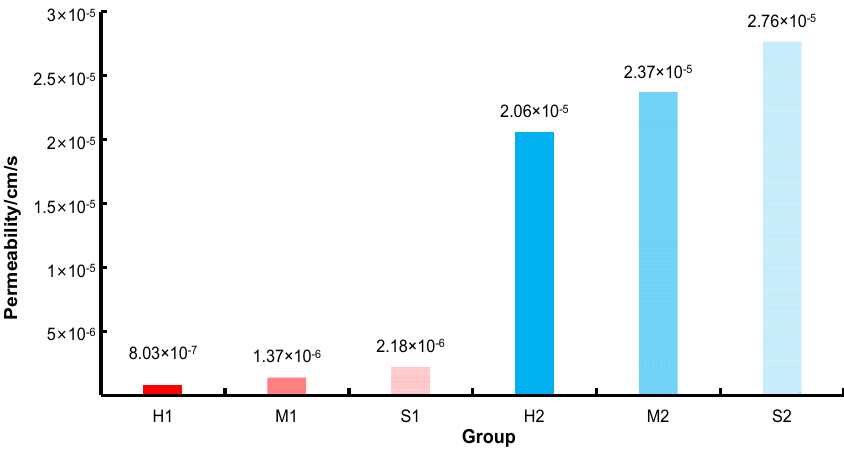
Figure 9. Permeability test of specimens.